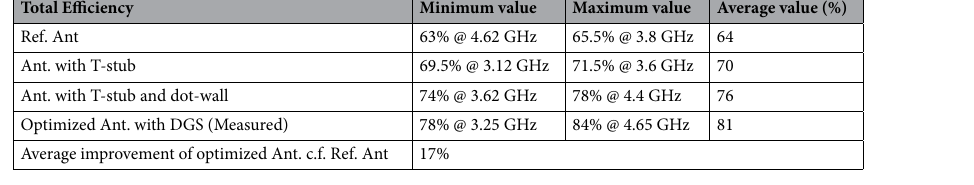
Table 4. Antenna array total